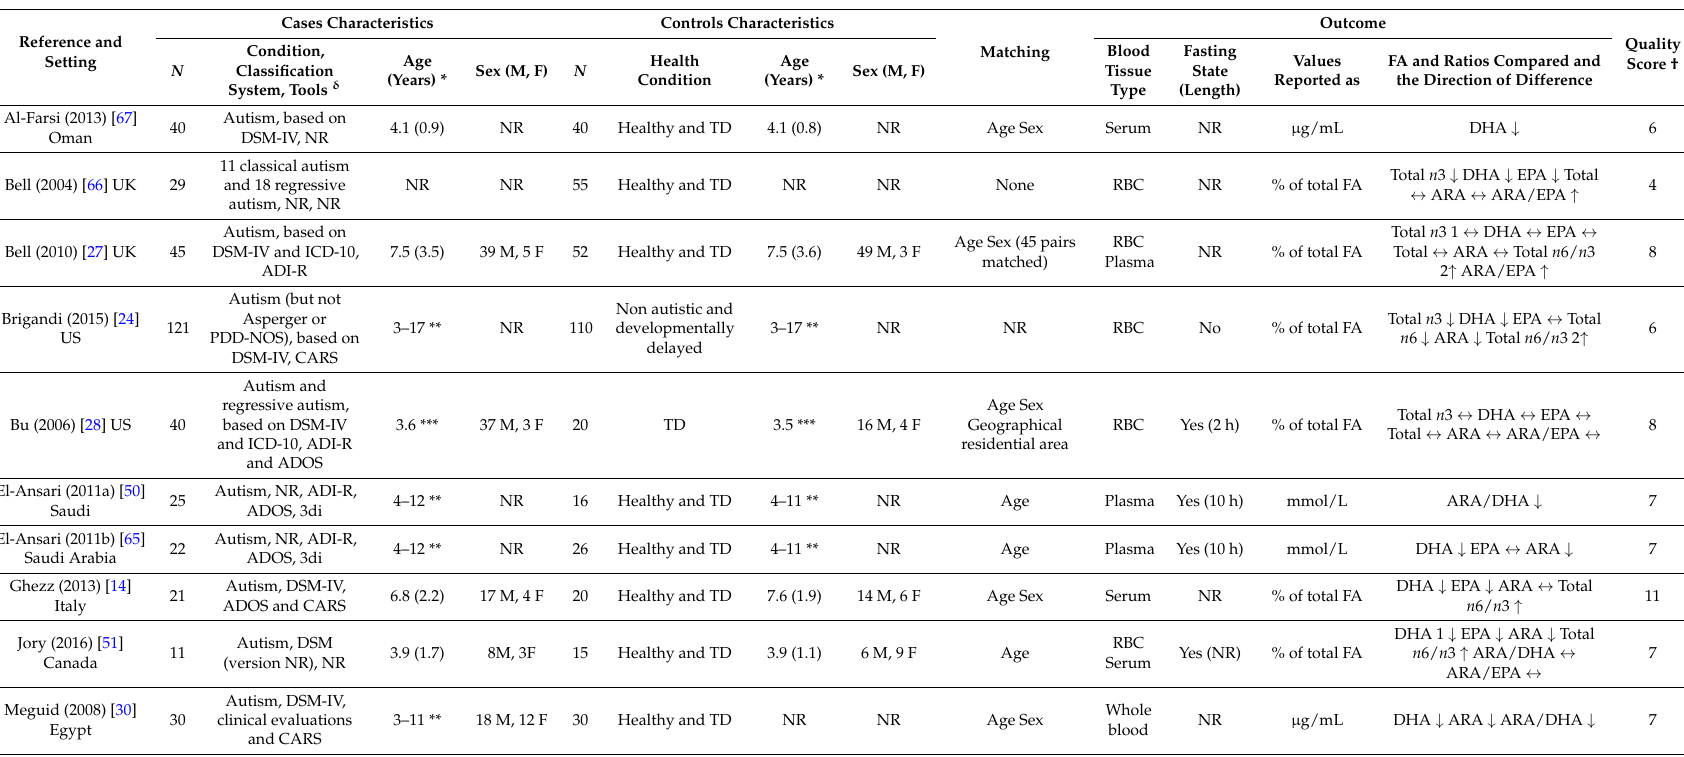
Table 1. Characteristics of case-control studies included in meta-analysis